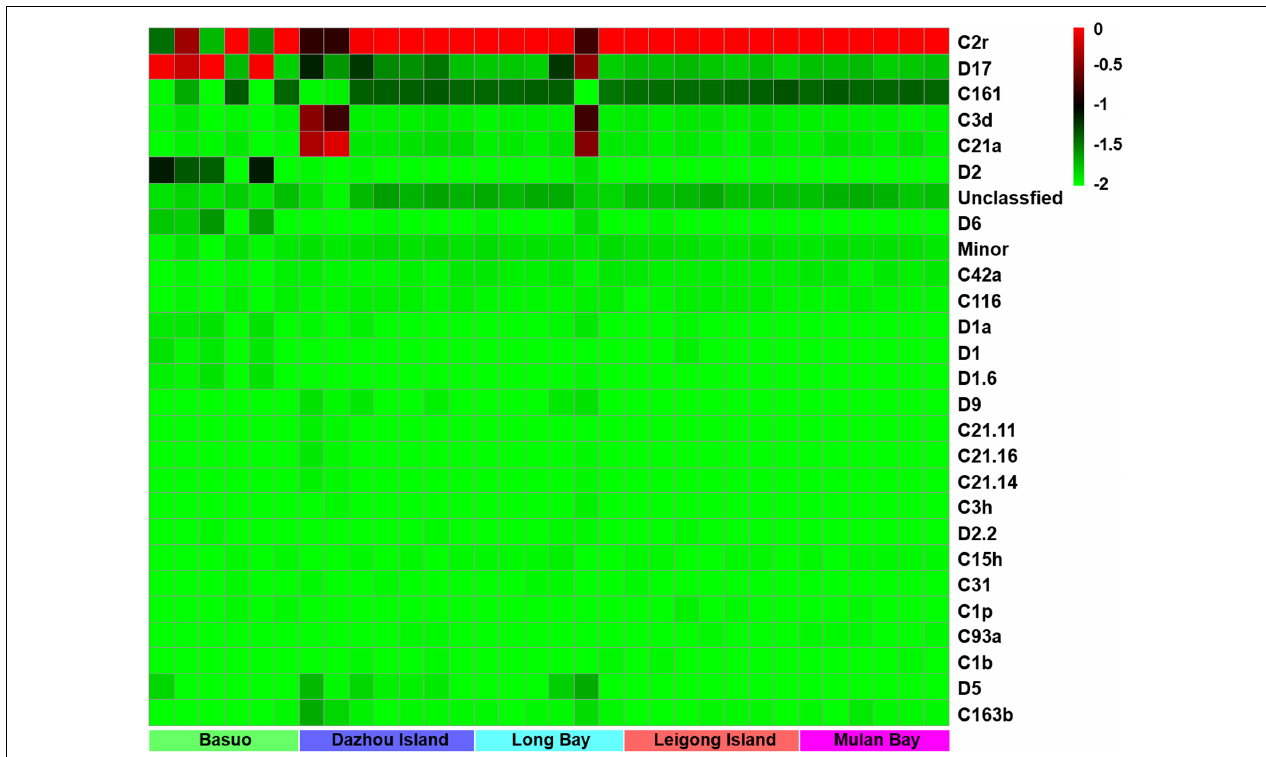
FIGURE 4 | A heatmap visualization of the dominant subclades of Symbiodinium (relative abundance > 0.1% in one sample at least). The top scales “–2, –1.5, –1, –0.5, and 0” showed the relative abundance of “0, 2, 9, and 99%,”